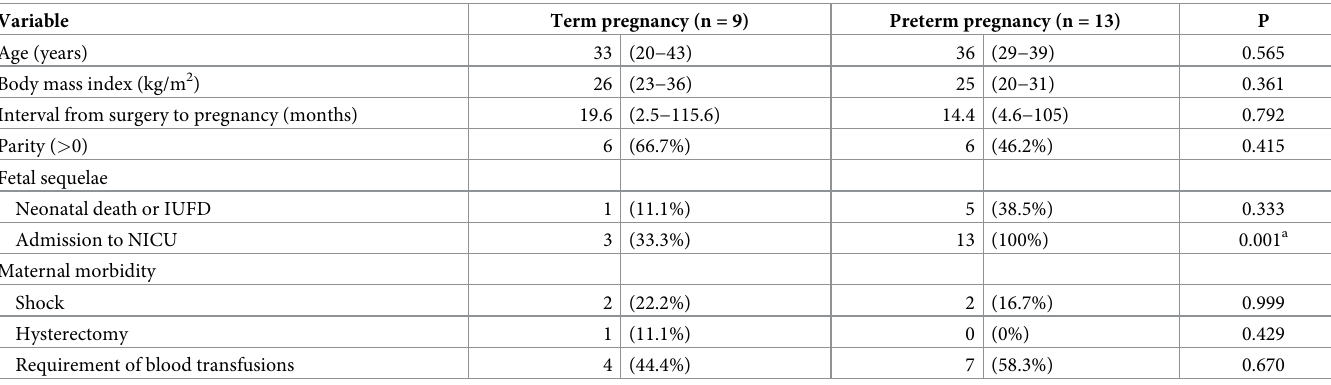
Table 2. General characteristics, fetal sequelae, and maternal morbidity of women with uterine rupture classified according to term versus preterm pregnancy.